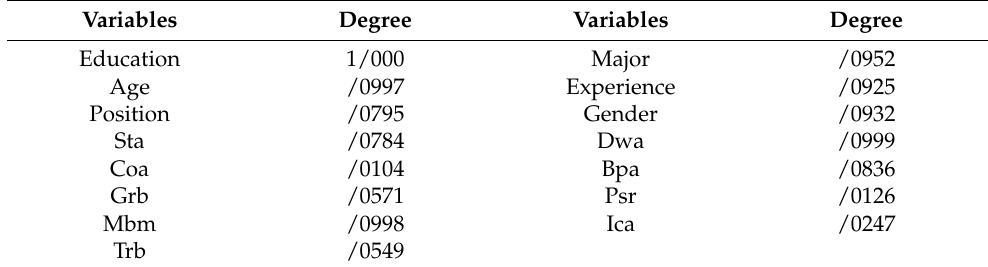
Table 8. The results of variable normality.